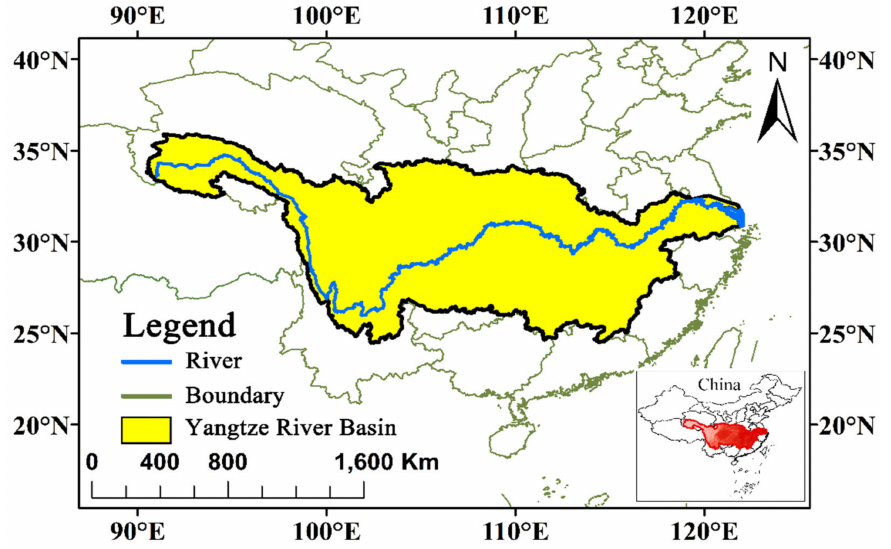
Figure 1. The study area of the Yangtze River